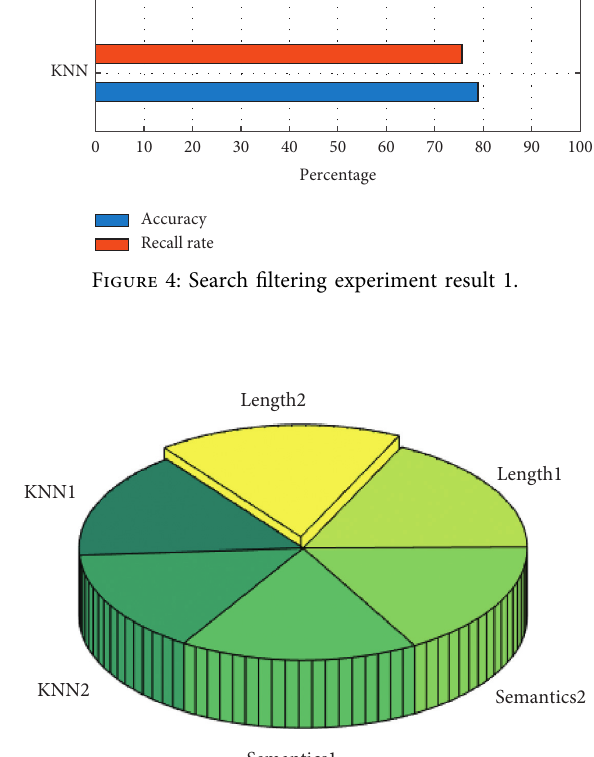
Figure 5: Results of the search filter experiment